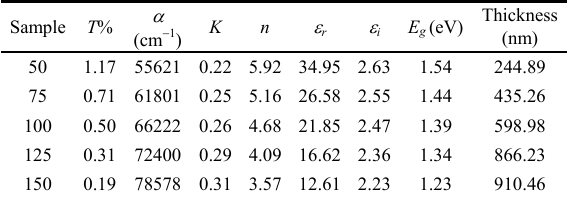
Table 3 Optical parameters for (Ti6Al4V) films at the different